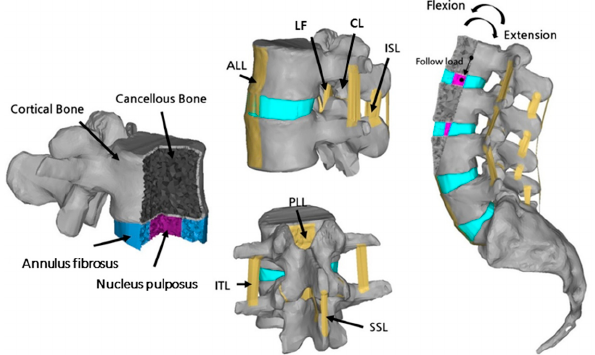
Figure 1. Modeling the three-dimensional (3D) structure of the spine and loading conditions (ALL: Anterior longitudinal ligament; PLL: Posterior longitudinal ligament; LF: Ligamentum flavum; CL: Capsular ligament; ISL: Interspinous ligament; SSL: Supraspinal ligament; ITL: Intertransverse ligament).